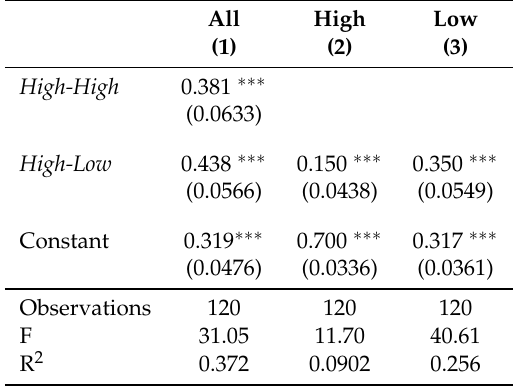
Table 5. Linear regressions: helping rates in Part B-merged group treatment